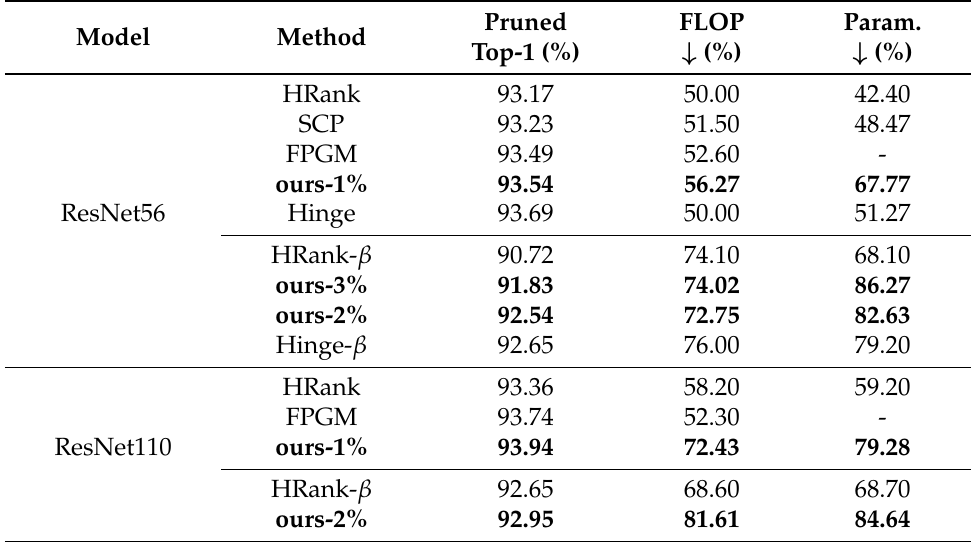
Table 4. Pruning results on Cifar10. Ours-1%, Ours-2% and Ours-3% refers to our methods with 1%, 2% and 3% ACC D . HRank- β is the HRank with a different compression target and the same for other